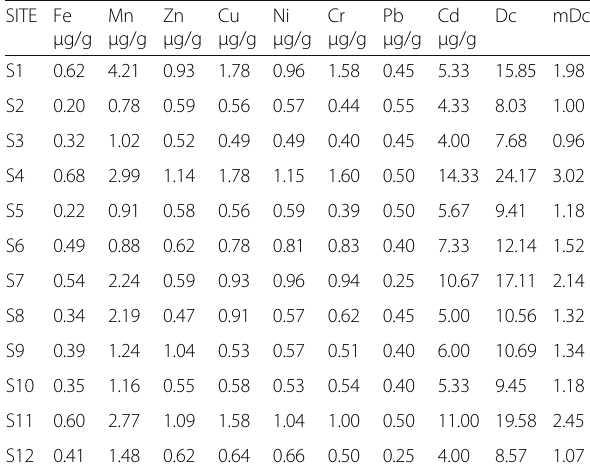
Table 11 Contamination factor 2010